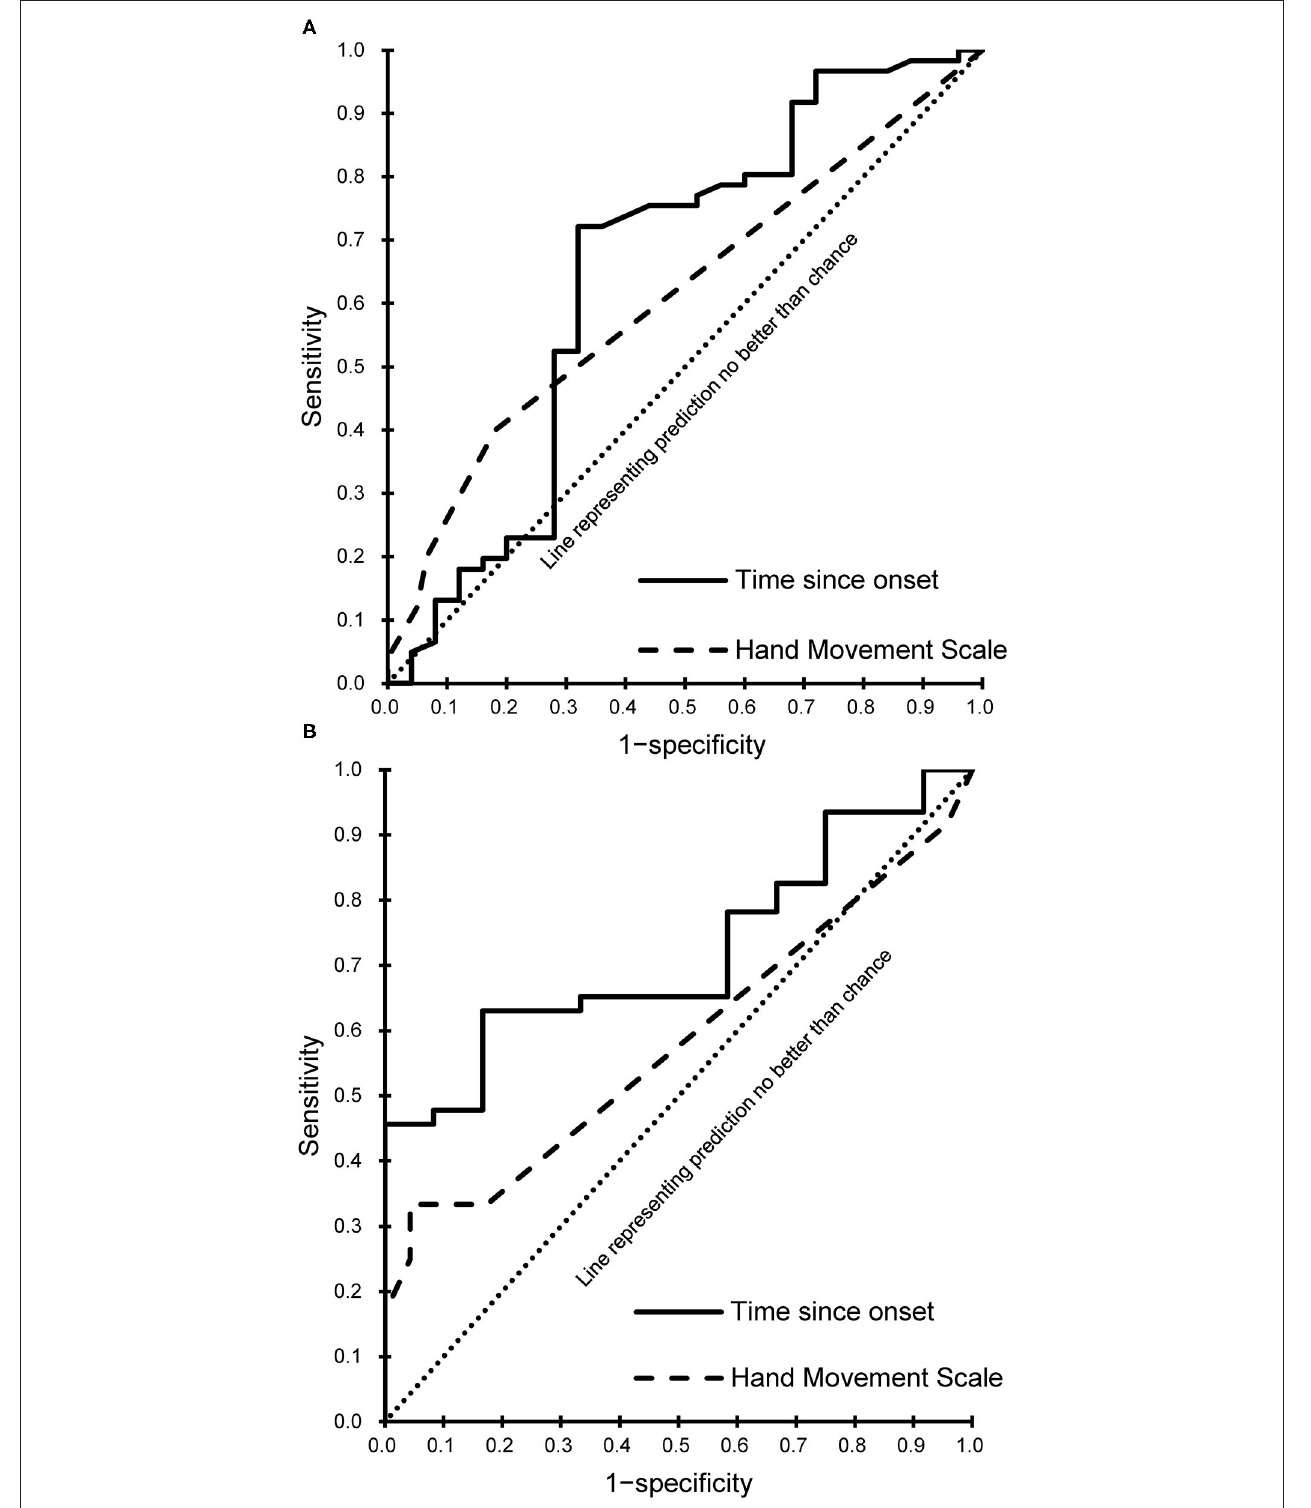
FIGURE 3 | Receiver operating characteristic curves of the meaningful predictors. (A) Subacute phase. (B) Chronic phase.